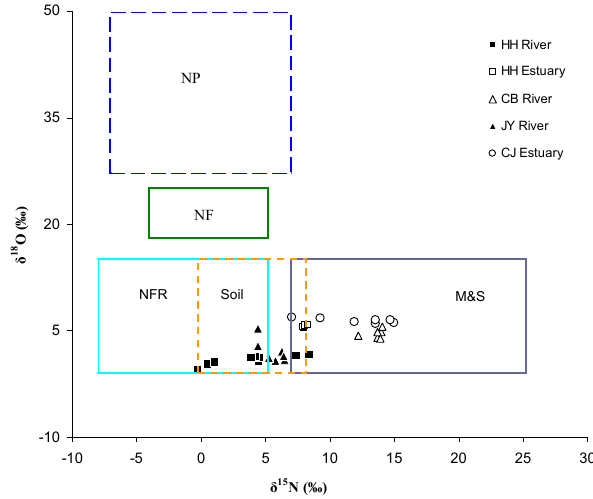
of the salinized rivers and estuar- Figure 2. δ 15 N– and δ 18 O–NO − 3 ies. Ranges of isotopic composition for five potential NO − sources 3 are adapted from Kendall et al. (2007) and Xue et al. (2009) and in- dicated by boxes: NO − in precipitation (NP), NO − fertilizer (NF), 3 3 NH + in fertilizer and rain (NFR), soil N (Soil) and manure and 4 sewage (M&S). To provide a more wide and clear range of δ 18 O– NO − values, the upper limit of NP reaches 3